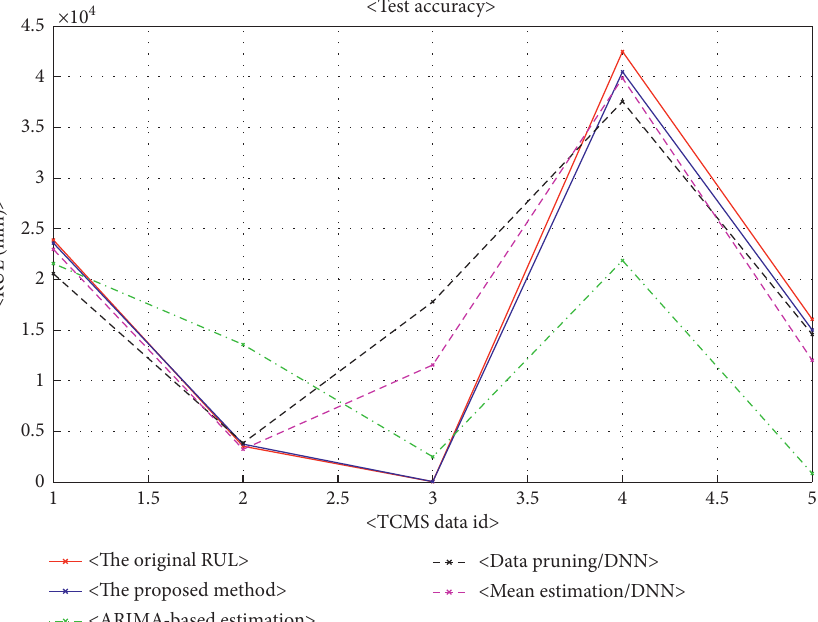
Figure 7: Test accuracies using the four benchmarking methods.